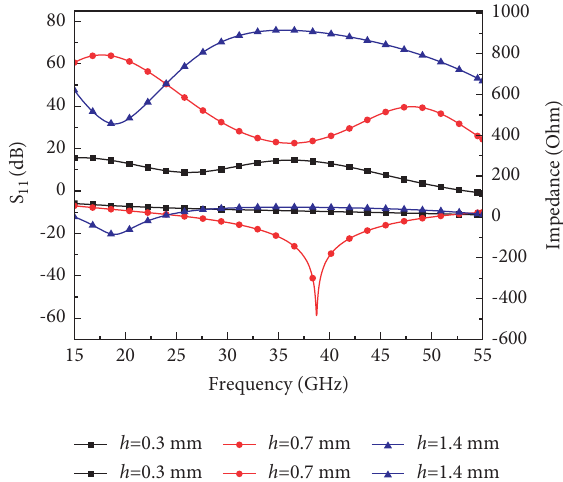
Figure 13: Reflection coefficient (left column) and input imped- ance (right column) at different substrate